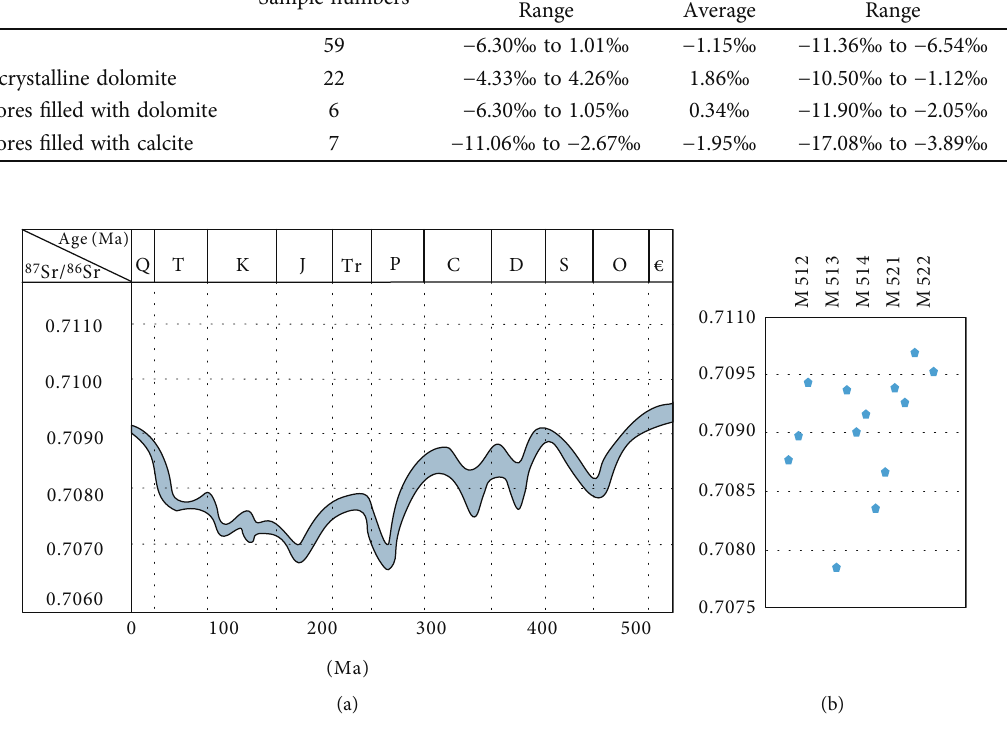
Figure 5: 87 Sr/ 86 Sr distribution of strontium isotope. (a) Global Quaternary Cambrian strontium isotopic evolution curve. (b) Strontium submember of Majiagou Formation of Middle Ordovician in Yan ’ an isotope 87 Sr/ 86 Sr distribution in M5 1-2